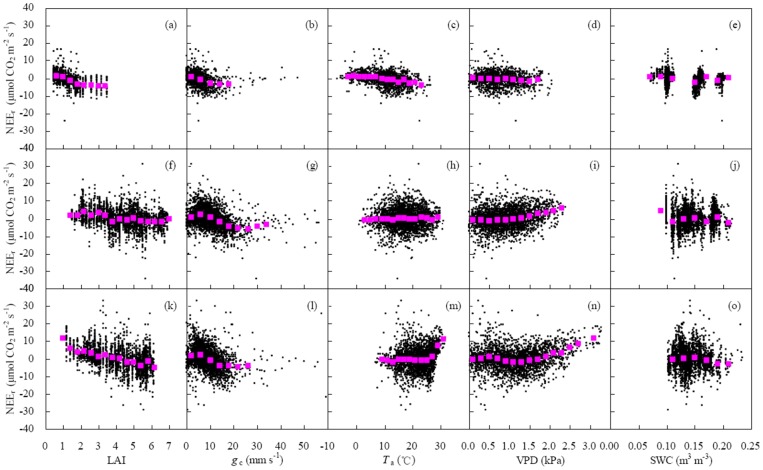
Effects of biophysical factors on NEE residual (NEEr) in a winter wheat field in March (a–e), April (f–j) and May (k–o).NEE residual was measured NEE minus simulated NEE. The simulated NEE was obtained by Eq. (3). Biophysical factors include canopy conductance (g
c), Leaf area index (LAI), daytime air temperature (T
a), vapor pressure deficit (VPD) and soil water content at the depth of 20 cm (SWC).